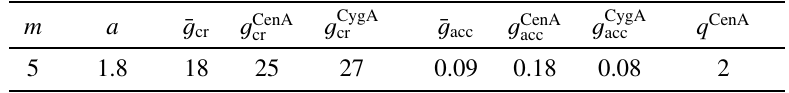
Table 1. Best-fit parameters using solar abundances for all sources except for Centaurus A.